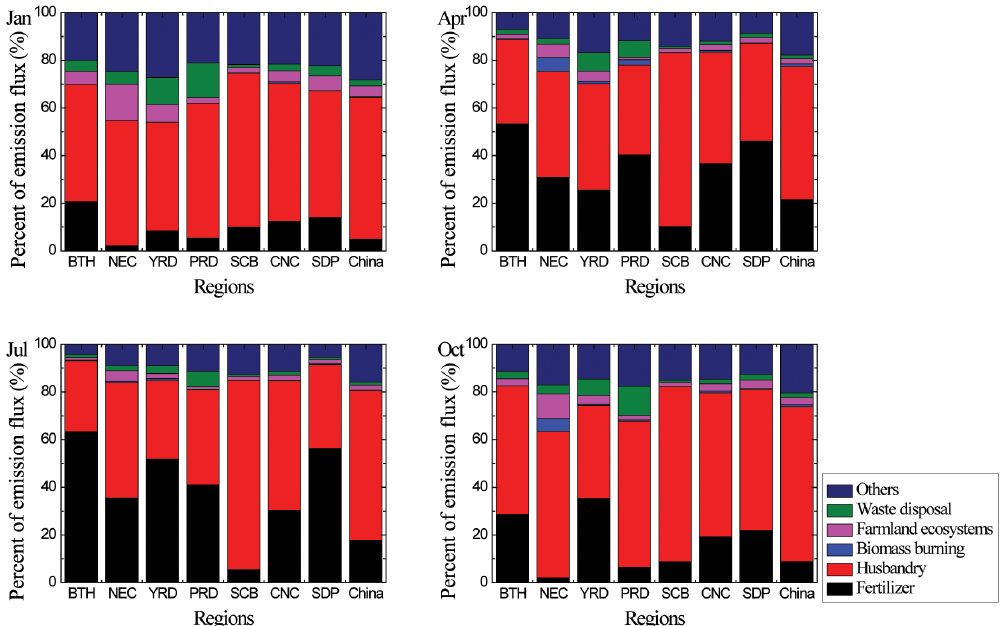
Figure A6. The percent (%) of different NH 3 emission sectors over each region in January, April, July, and October.